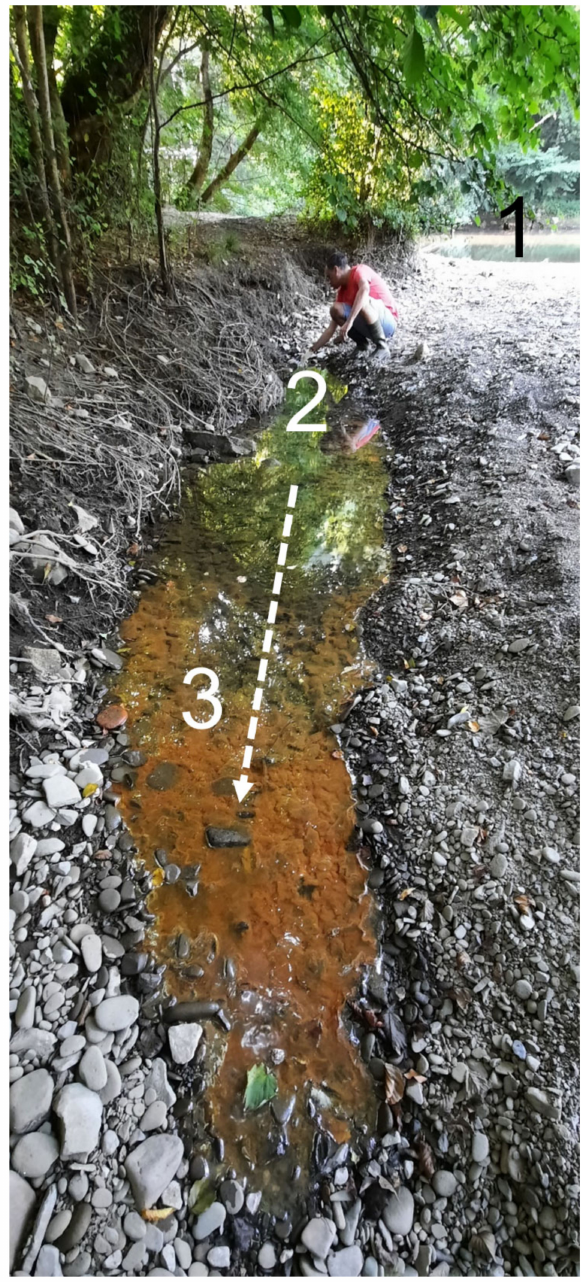
Figure 1. Location of the Smrdljivec spring (1—the Reka River, 2—main orifice of the Smrdljivec spring, 3—direction of the water flow before it sinks into the